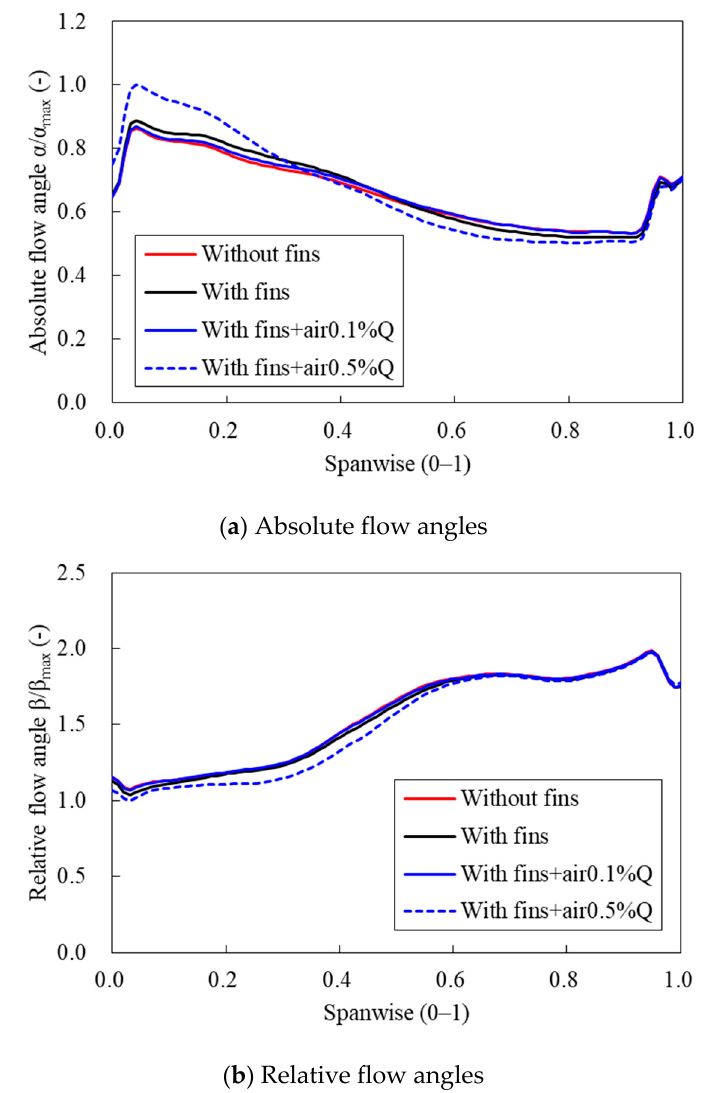
Figure 9. Flow angle distributions along the spanwise direction at the outlet of the runner.